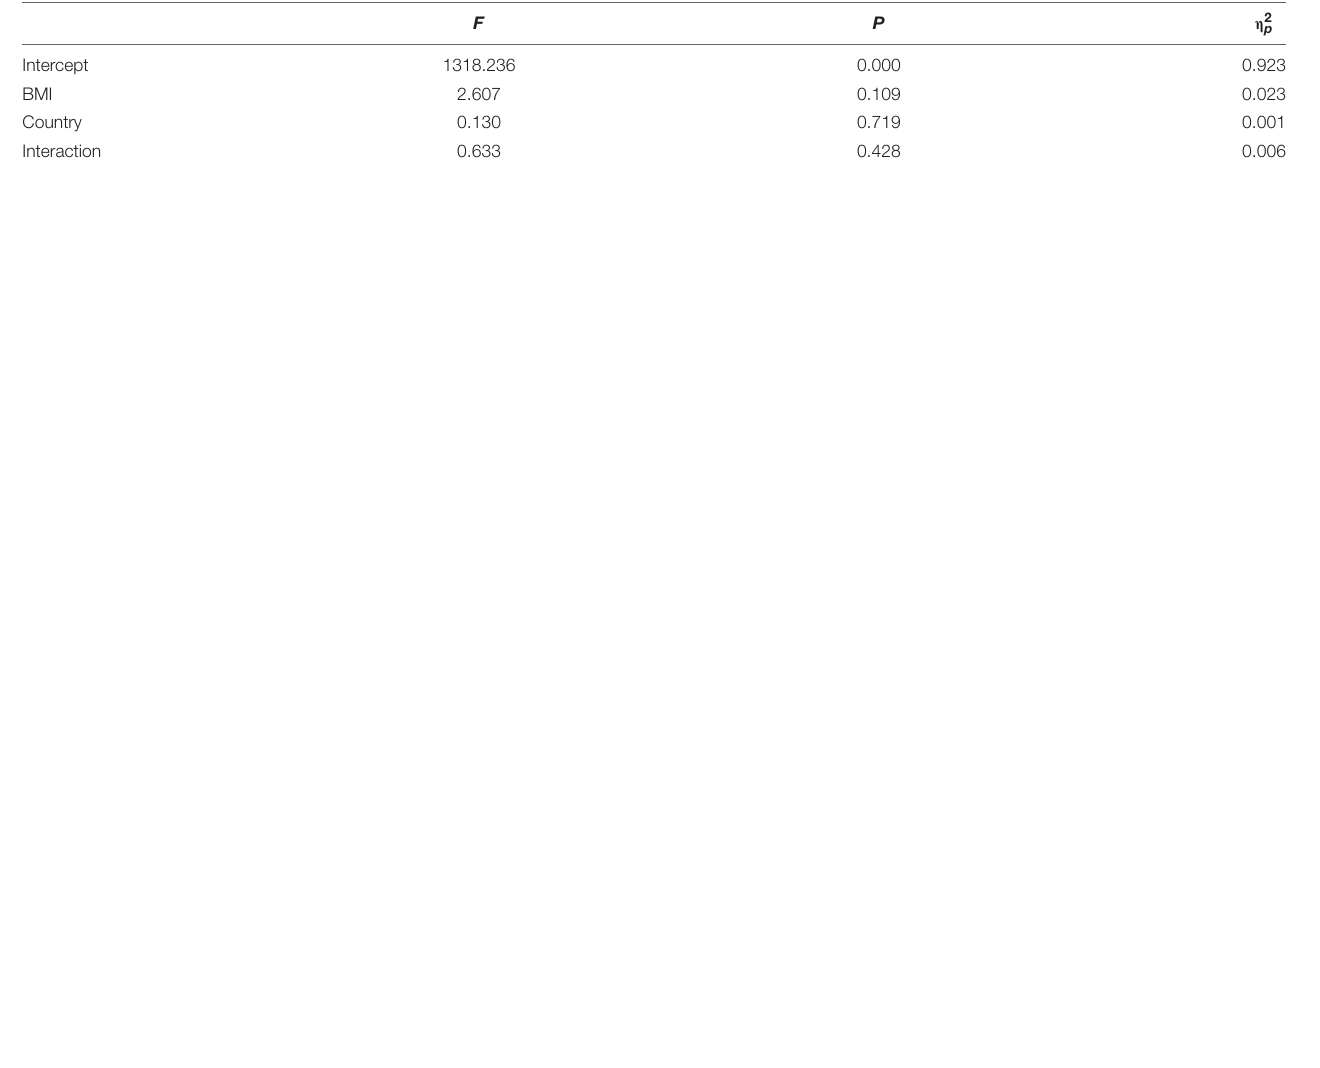
TABLE A2 | BMI – condition